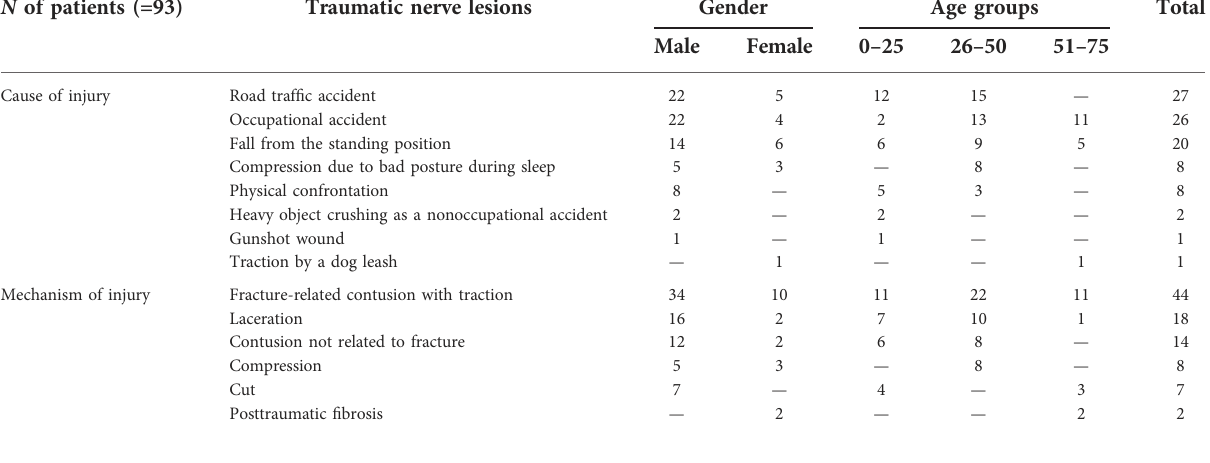
TABLE 5 Causes and mechanisms of traumatic radial nerve injuries.